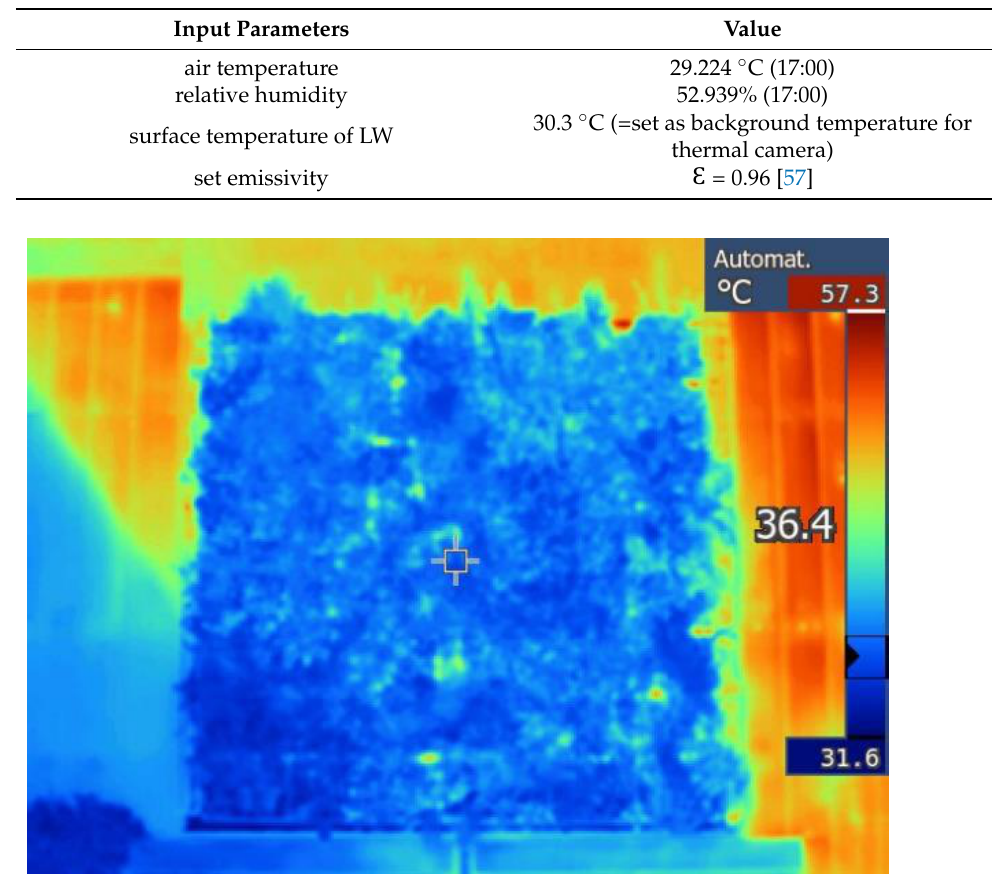
Figure 4. Thermal camera FLUKE TI27 image with accuracy +/ − 2 °C, 26 July 2021. The resulting thermal camera image showed that under the actual measurement conditions, the centre of the LW is almost 20 °C cooler than its surroundings (in this case, the sheet metal facade). In the middle of this LW, 36.4 °C was measured, while the highest temperatures on the surrounding facade reached up to 57.3 °C.